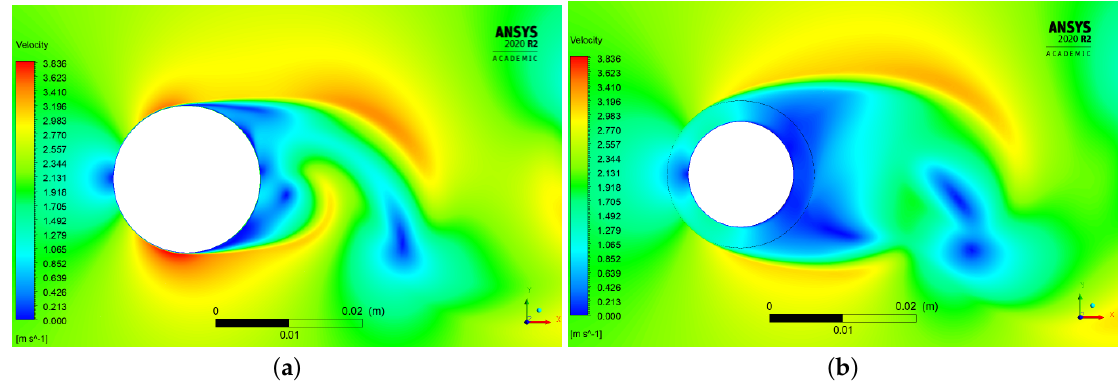
Figure 10. Instantaneous contours of velocity at Re = 4.2 × 10 4 . ( a ) Smooth cylinder (diameter D ). ( b ) Fully coated cylinder (thickness t / D = 14.3% and a porosity of 20 PPI). The black circle indicates the outer diameter D of the porous